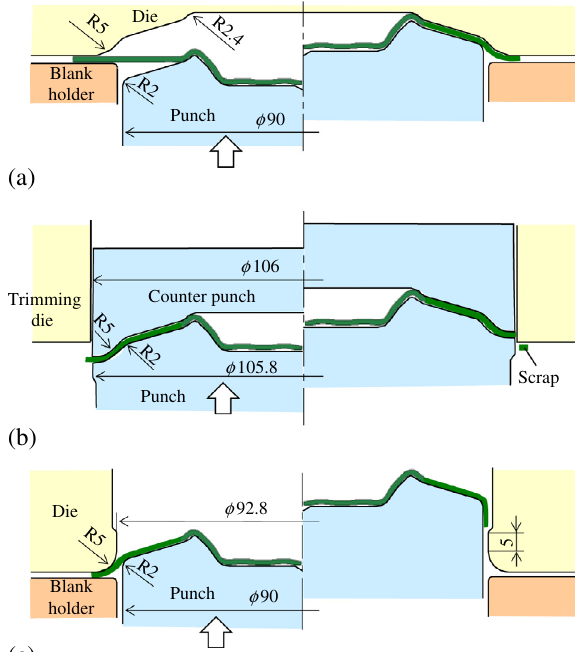
Figure 16. Conditions for forming of wheel disk: (a) 4th stage, (b) 5th stage and (c) 6th stage.